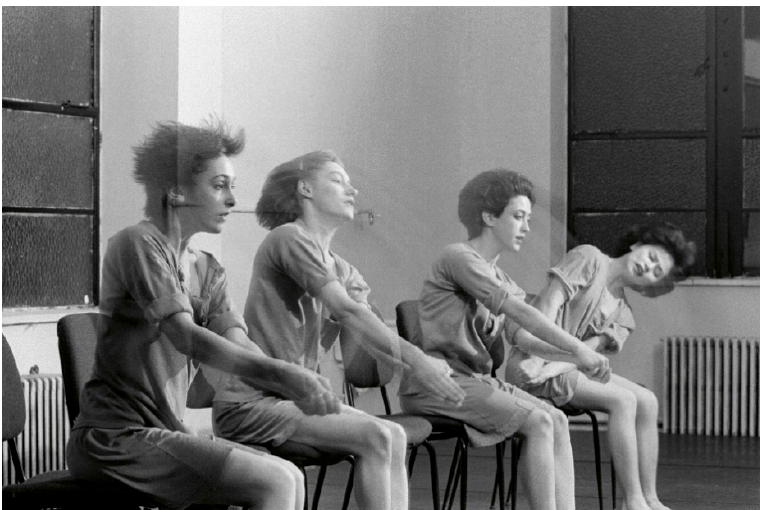
Figure 11. Rosas danst Rosas (1983) Anne Teresa De Keersmaeker/Rosas @ Jean-Luc Tanghe. Used with permission.